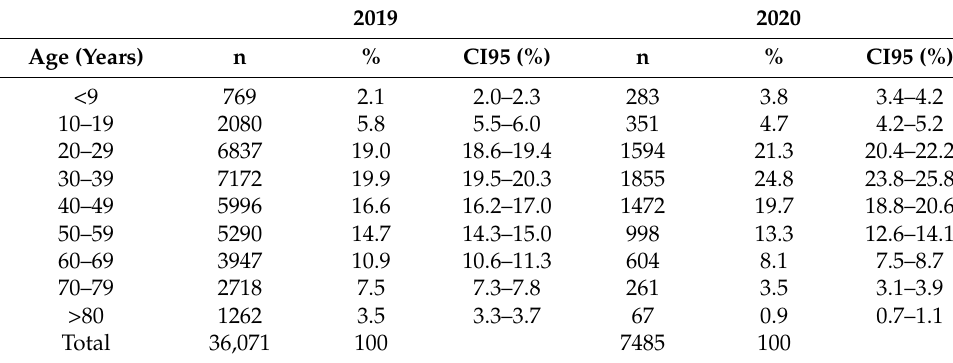
Table 1. Distribution of patients according to age